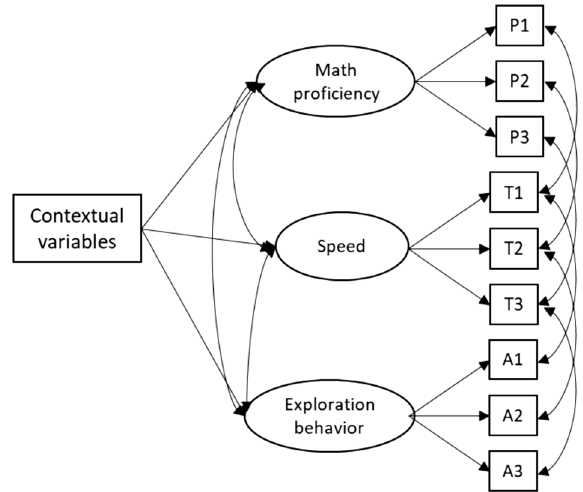
of actions in a joint framework with context